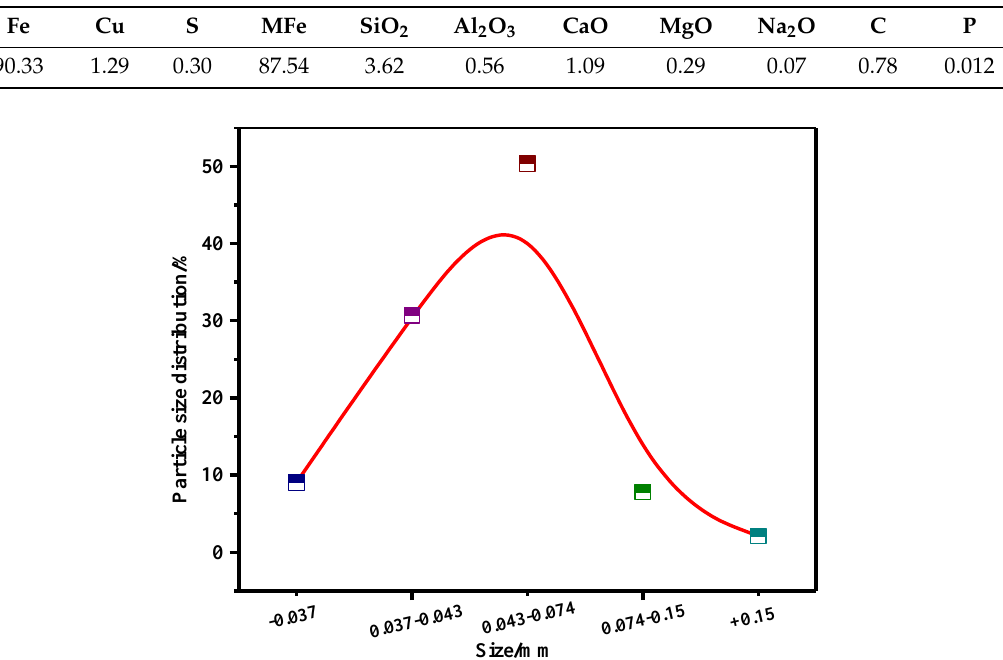
Table 1. Chemical compositions of CBDRI (wt %).